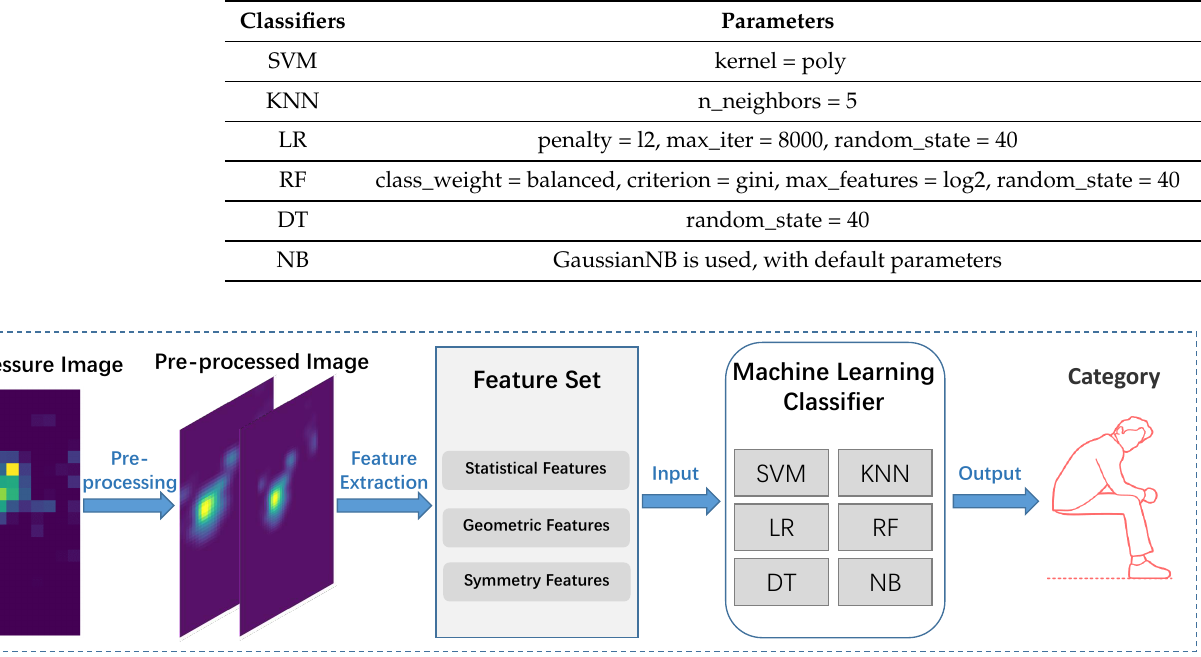
Figure 6. The workflow of classical machine learning method.